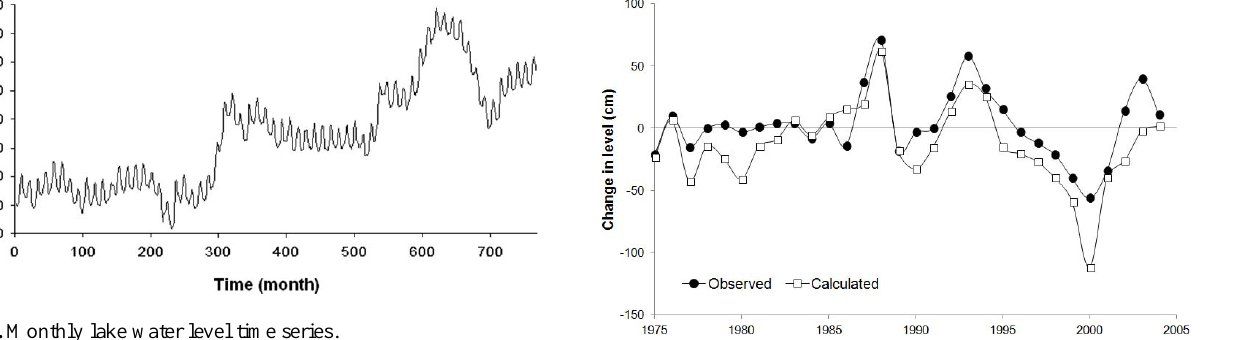
Fig. 3. Observed and calculated change in the lake water level rela- tive to previous